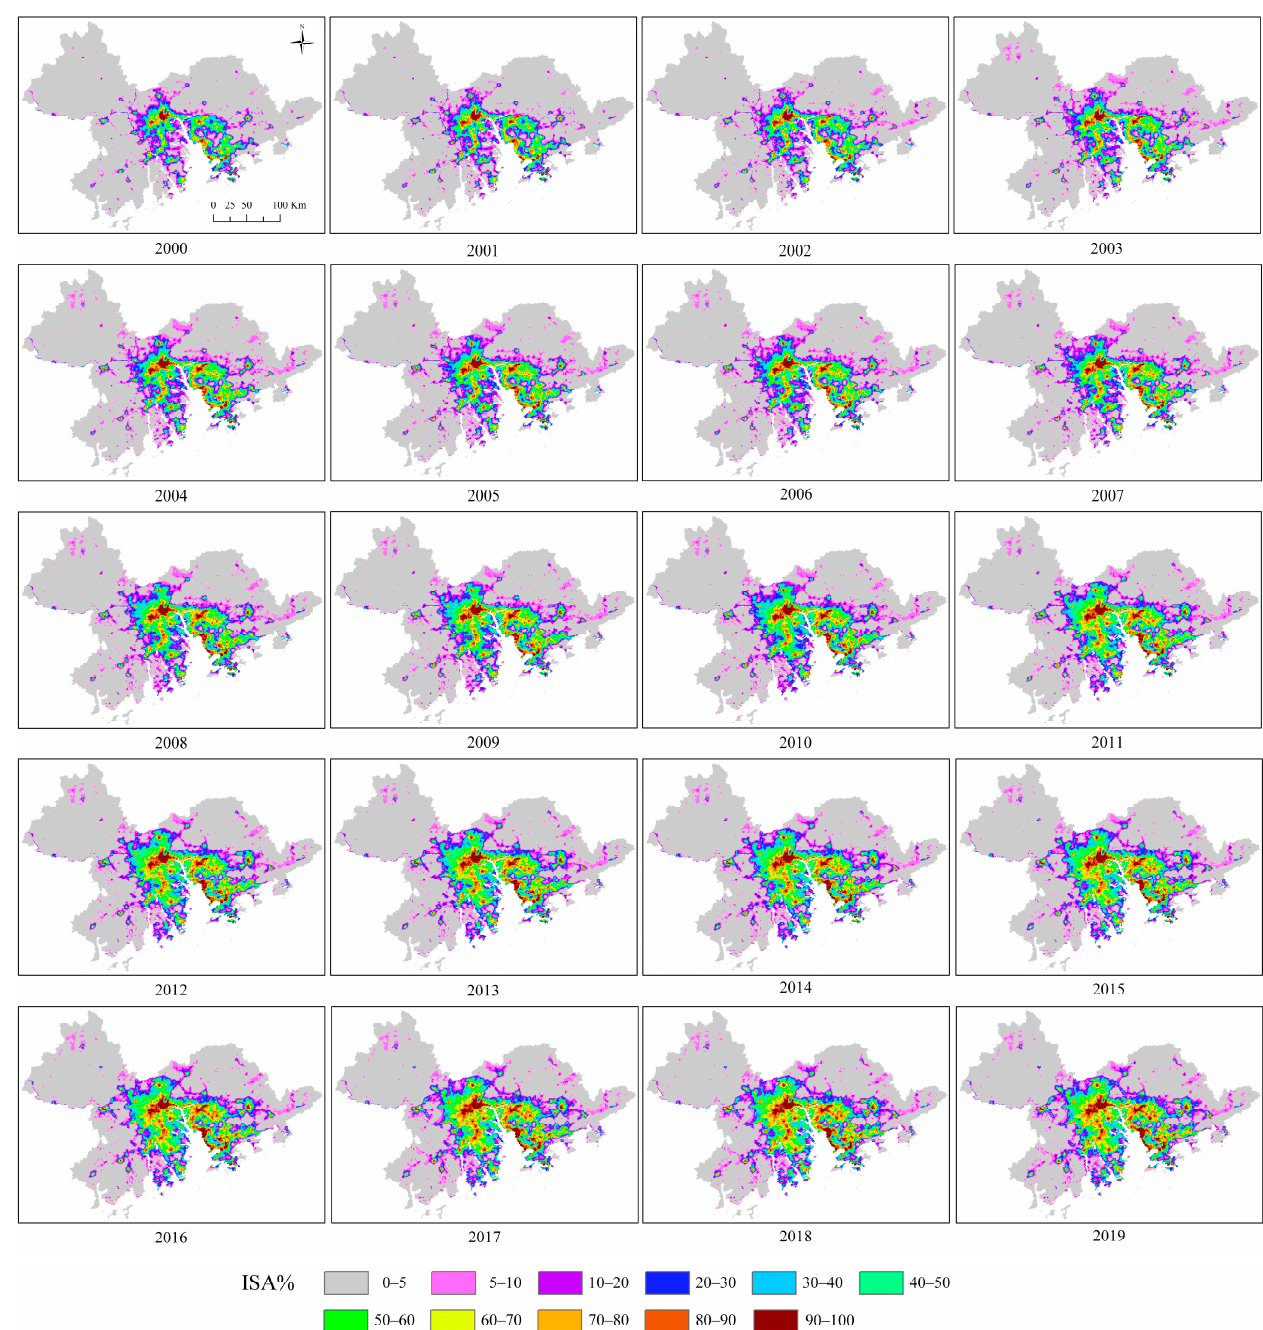
Figure 7. Dynamics of ISA% in Guangdong–Hong Kong–Macao Greater Bay, China, from 2000 to 2019.